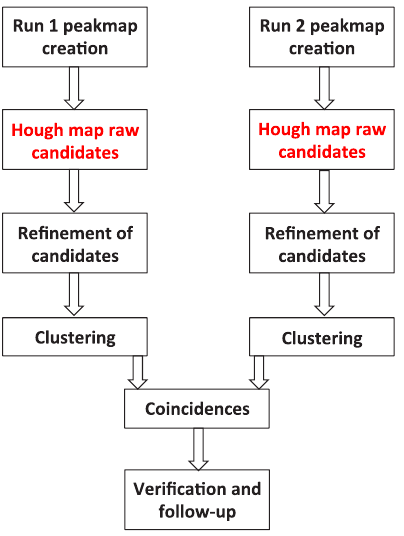
Figure 1. A scheme that shows the steps of the full FrequencyHough pipeline. They are summarized in Section 2 and described in detail in [7]. The FrequencyHough transform and the candidate selection, highlighted in red, are the parts of the pipeline that have been ported on